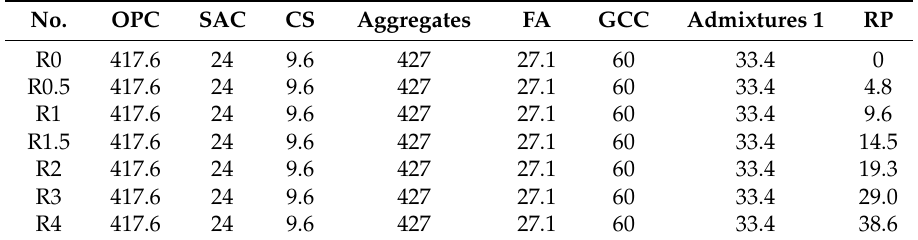
Table 3. Composition of SLM mix formulations (kg/m 3 ). CS, calcium sulfate; GCC, ground calcium